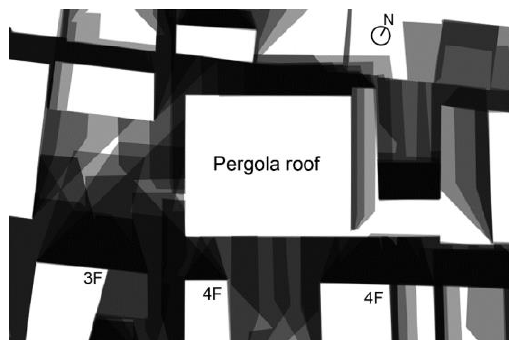
Figure 5. Shadow analysis conducted on 1 January on a 9 m pergola structure to be built on the research subject location (28.9° N, 13.4° E, UTC+1).